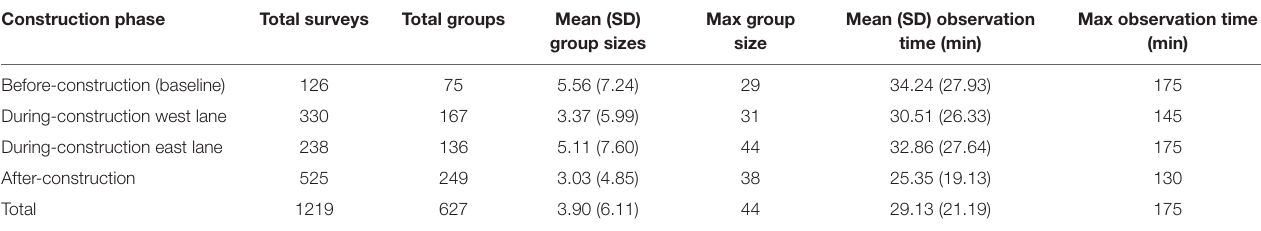
TABLE 1 | Survey effort before, during, and after bridge